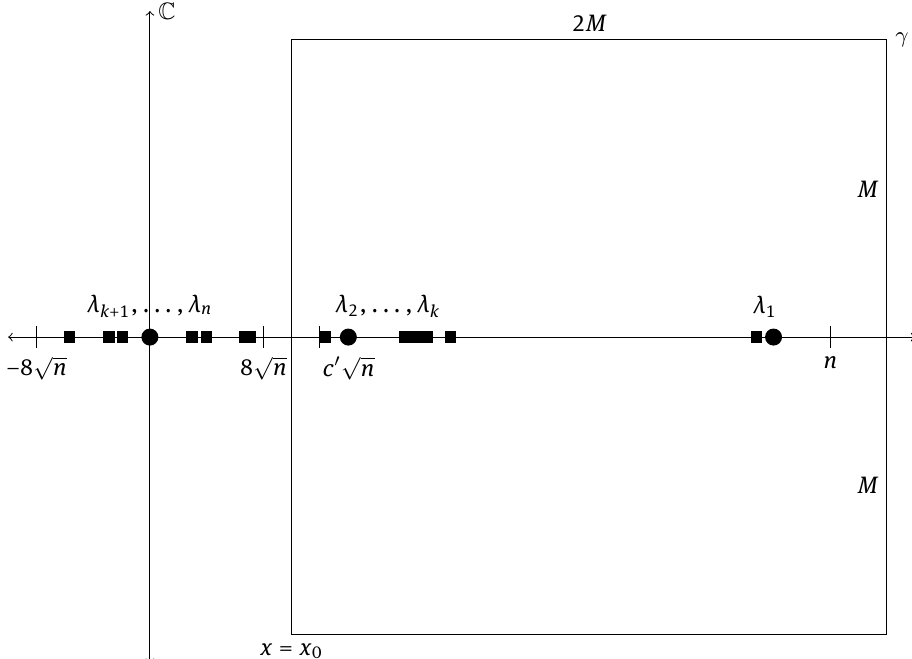
• ) and ˆ A ( (cid:4) ) are in the interior of γ , while the remaining n − k eigenvalues are in